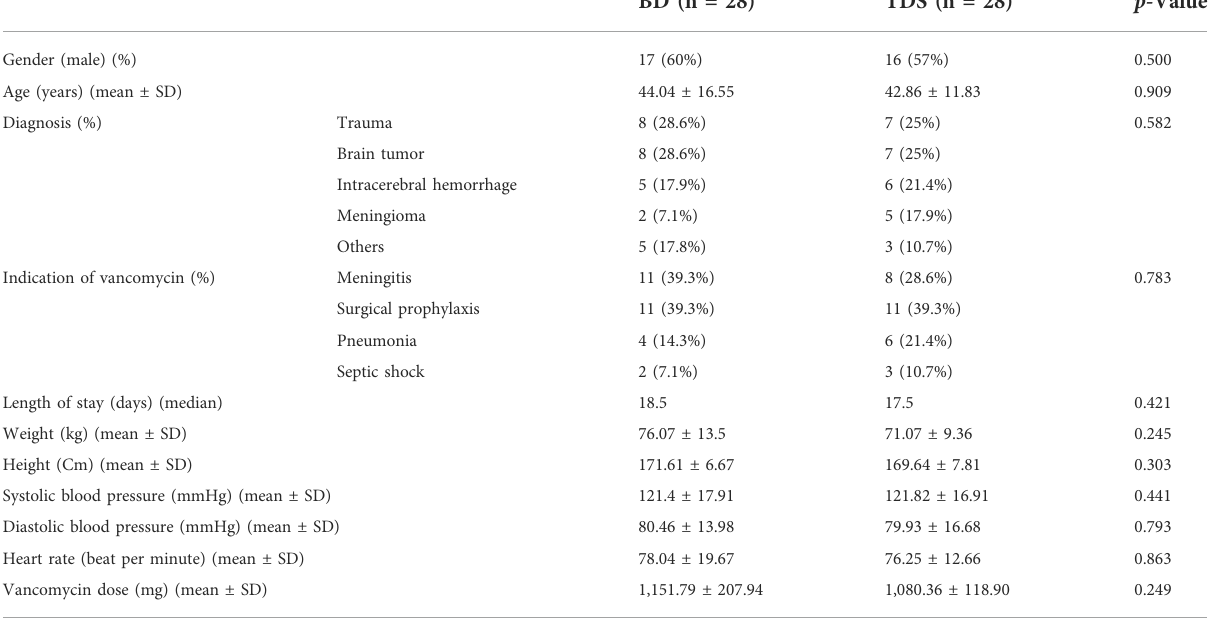
TABLE 2 Patient demographics.